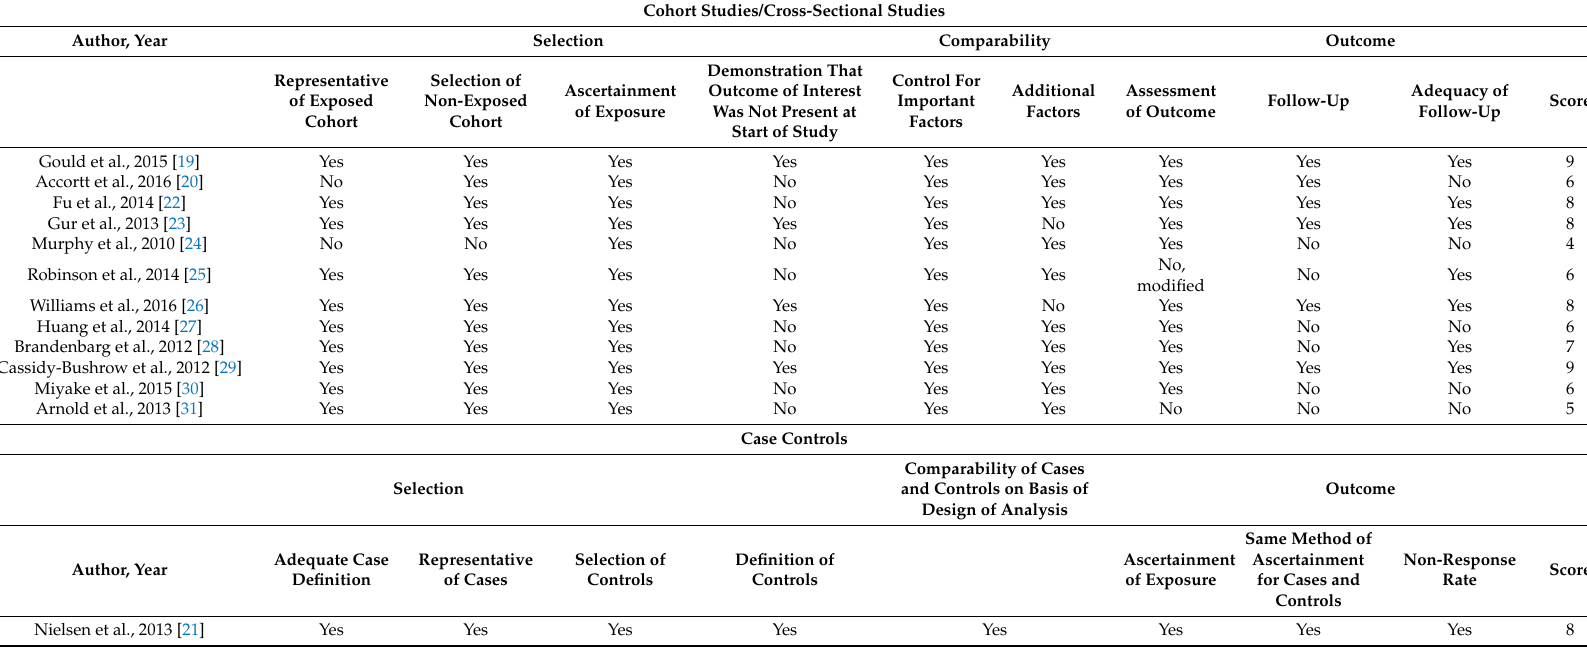
Table 3. Quality assessment of included